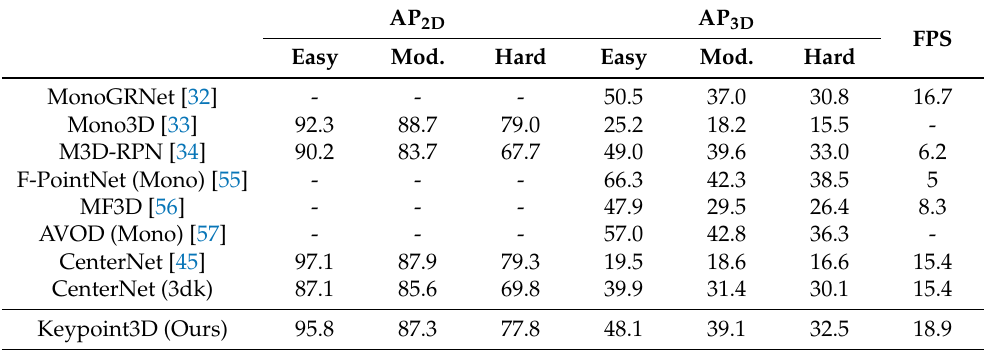
Table 2. The 2D and 3D detection performance comparison between Keypoint3D and state-of-the-art methods as per the KITTI benchmark in car category. FPS indicates the inference speed, and 3dk denotes the utilization of 3D projected keypoints in CenterNet [45]. All the methods in trained and evaluated on the KITTI train and val set. AP 2D and AP 3D indicates the 2D and 3D object detection average precision with the IoU set as 0.7 and 0.5, respectively. AP 2D AP 3D FPS Easy Mod. Hard Easy Mod. Hard MonoGRNet [32] - - -